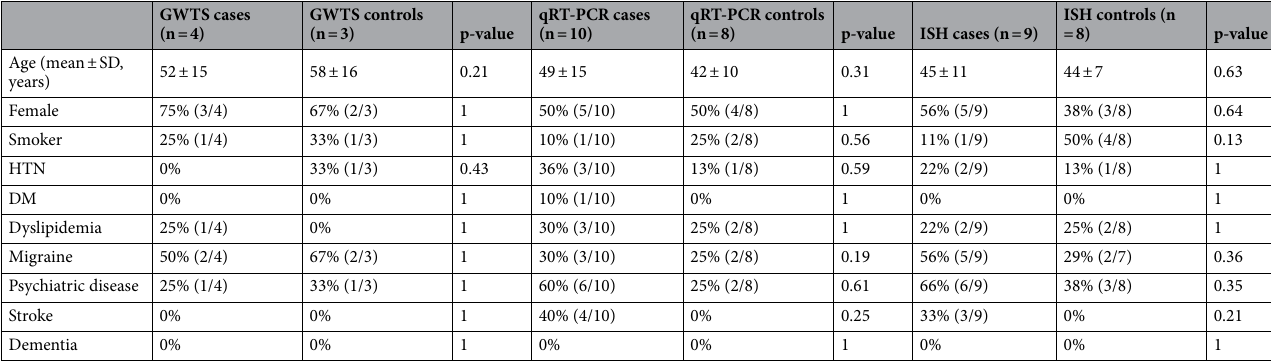
Table 1. Clinical-epidemiological features of the GWTS, qRT-PCR and ISH assay cohorts. HTN hypertension, DM diabetes mellitus.